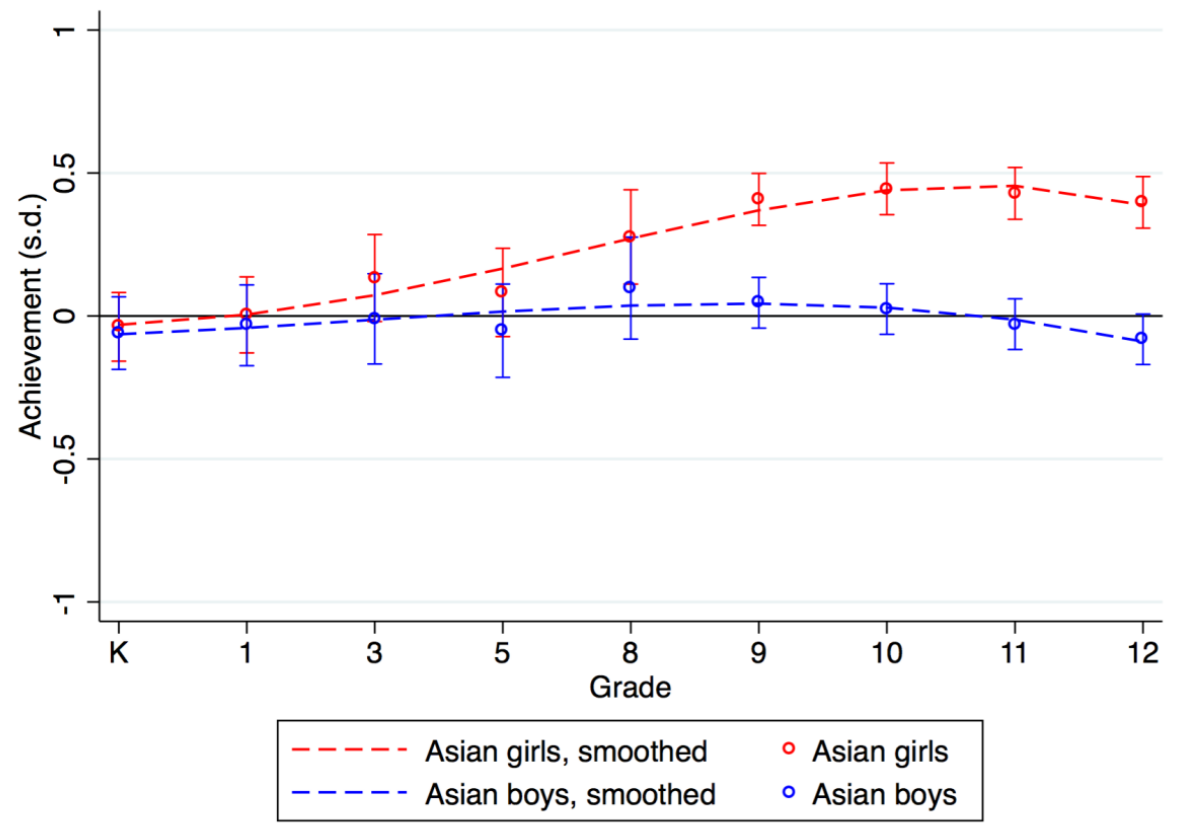
Figure 2: Gender gap in achievement among Asians. Note : The figure plots the predicted achievement scores for Asian American girls and boys from unadjusted school-fixed effect regressions. Kindergarten to eighth-grade scores come from the ECLS-K, and ninth- to 12th-grade scores come from the